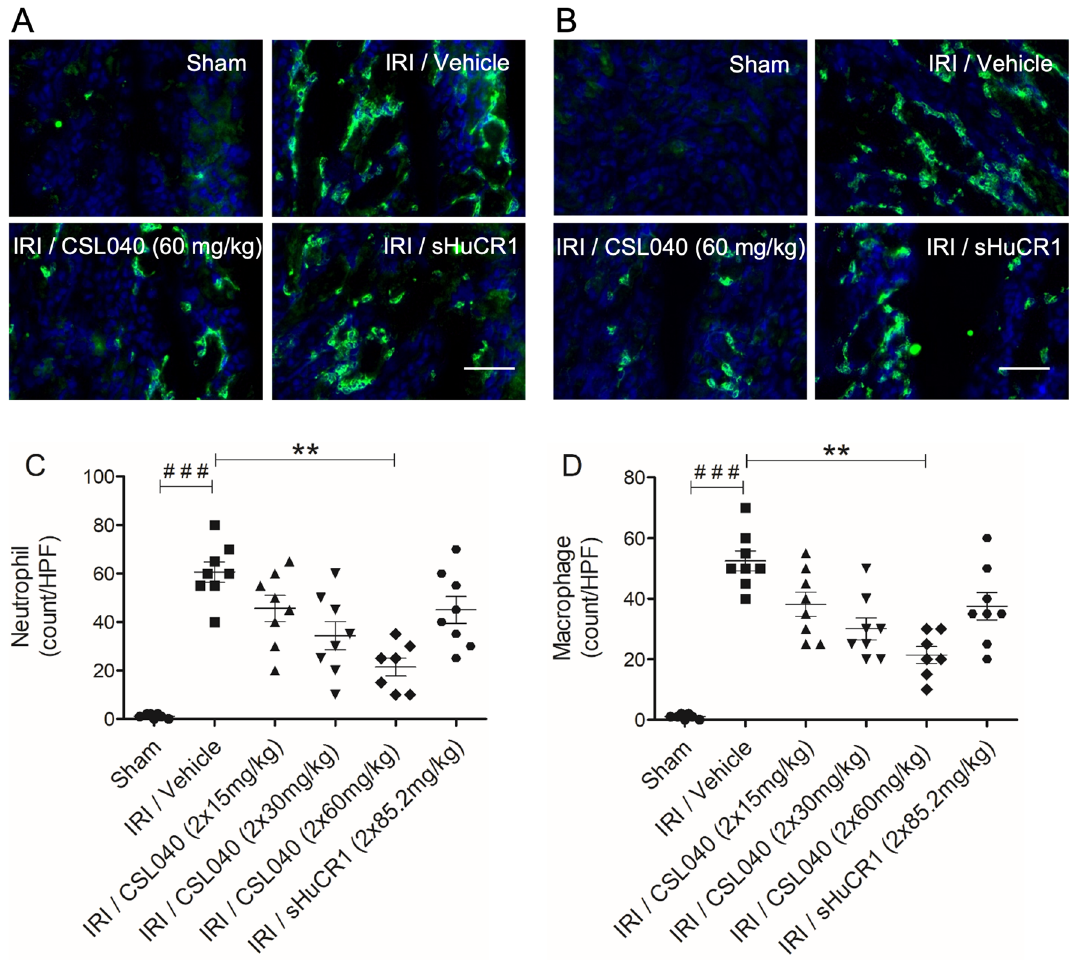
Figure 6. Reduction of IR-induced neutrophil and macrophage recruitment by CSL040 treatment. ( A , B ) Representative immunofluorescence images of neutrophil (Ly-6G positive) and macrophage (F4/80) kidney infiltration. Scale bar: 50 μm. ( C , D ) The numbers of neutrophil and macrophage infiltrate were expressed as count per high-power field (HPF), and quantitatively measured by image J analysis. Significance was tested using Mann–Whitney U test ( ### p < 0.001 for sham vs. IRI/vehicle), and One-way ANOVA Kruskal–Wallis and Dunn multiple comparisons test (**p < 0.01 for IRI/vehicle vs. all treatments). The data shown are mean ± SEM (n = 7–8 per